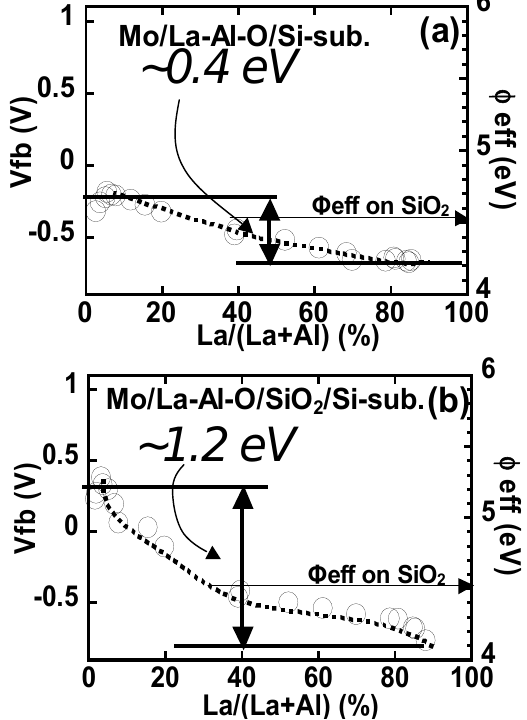
Figure 36. Plots of Vfb and φ eff as functions of La/(La+Al) for ( a ) Mo/La-Al-O/Si and /Si gate stack capacitors. ( b ) Mo/La-Al-O/SiO 2